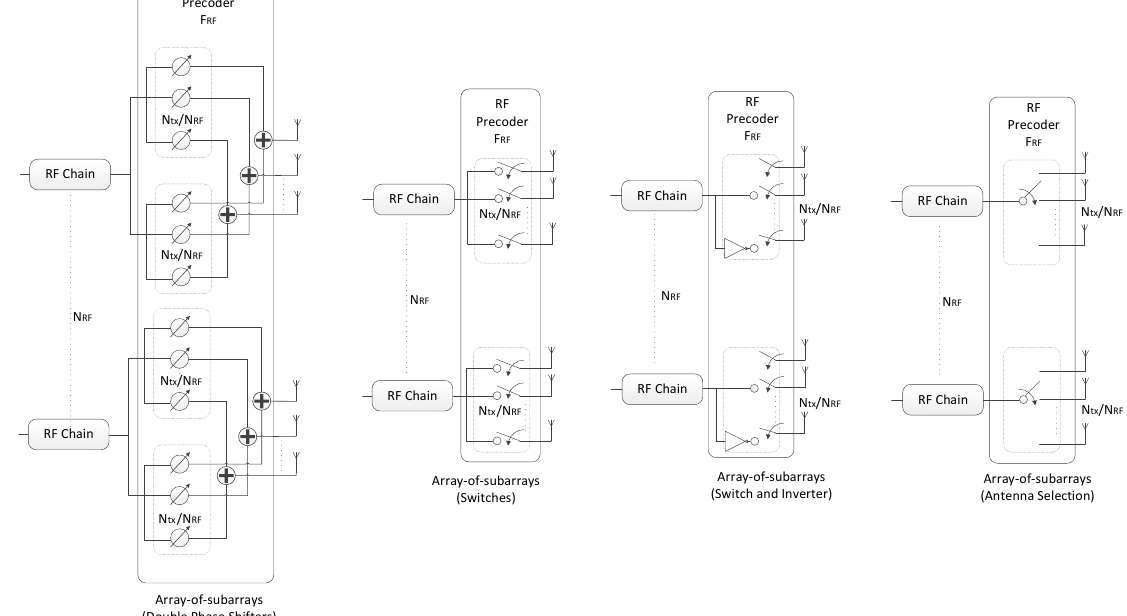
Figure 3. Alternative implementations to single phase shifters based on array-of-subarrays for a mmWave/THz MIMO system.